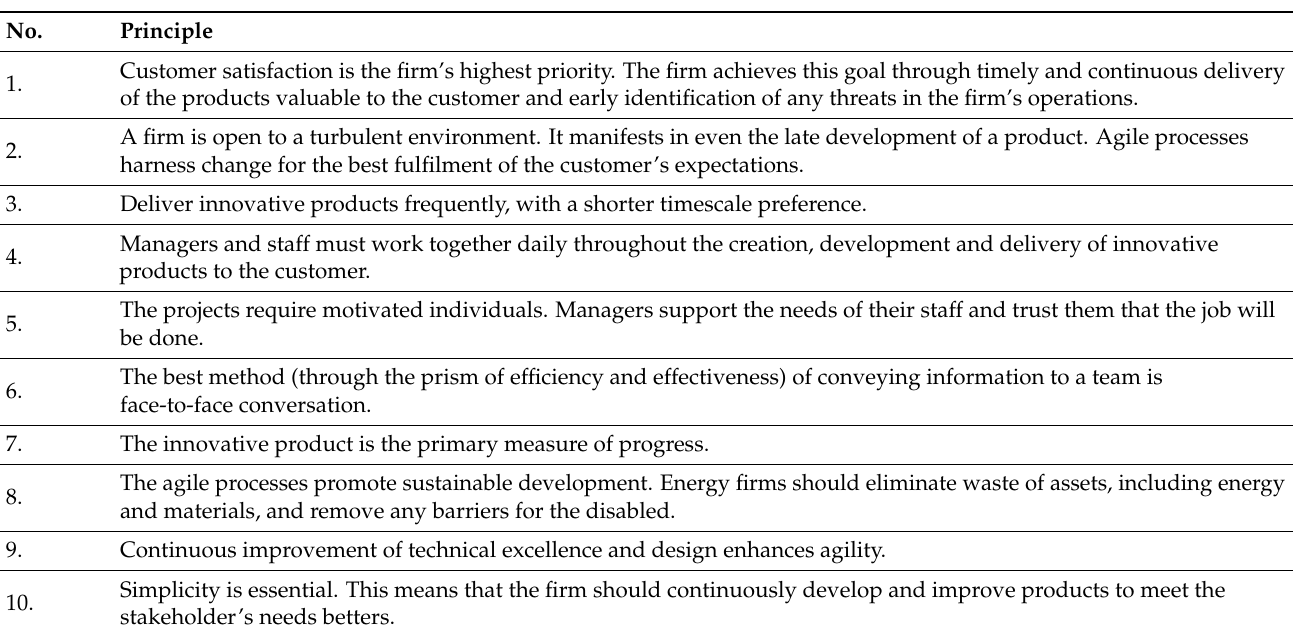
Table 1. Agile principles in energy